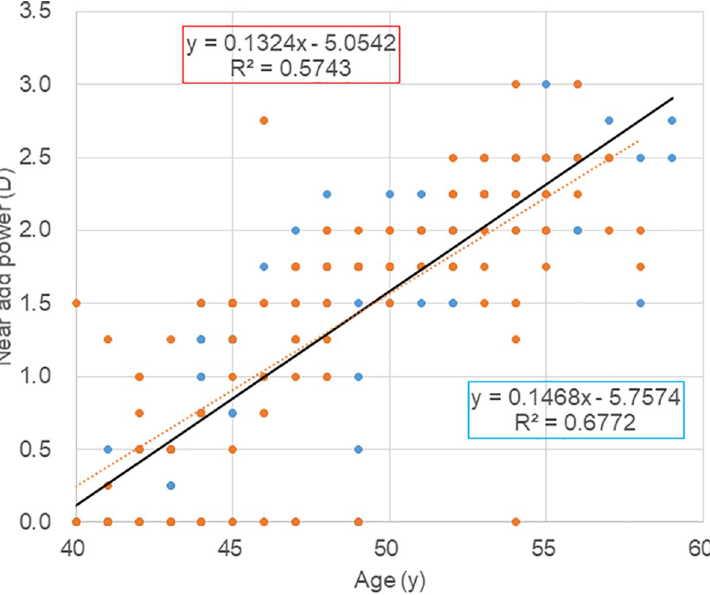
Fig 1. Scatter plots of near add power and age. Annual progression of near add power was similar in men (black circle, solid regression line) and women (red triangle, dotted regression line). Symbol overlap may not accurately represent the number of participants. The number of zero near power cases was 21 men and 26 women with no difference. It is also indicated by similar regression lines of both